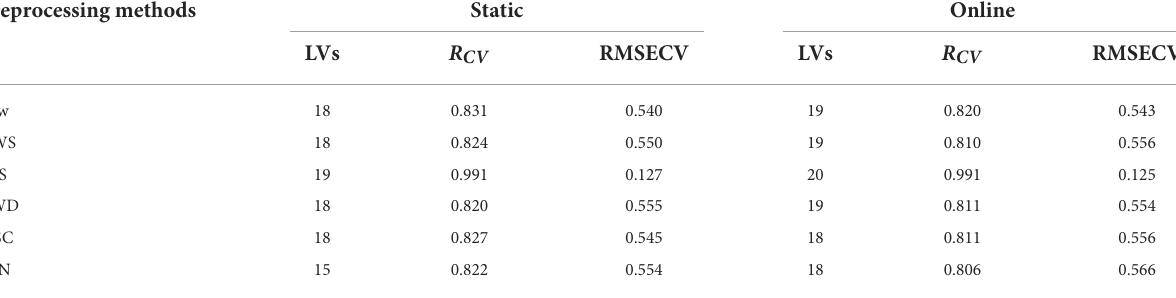
TABLE 2 The modeling results of snow peach SSC models with different spectral preprocessing methods.